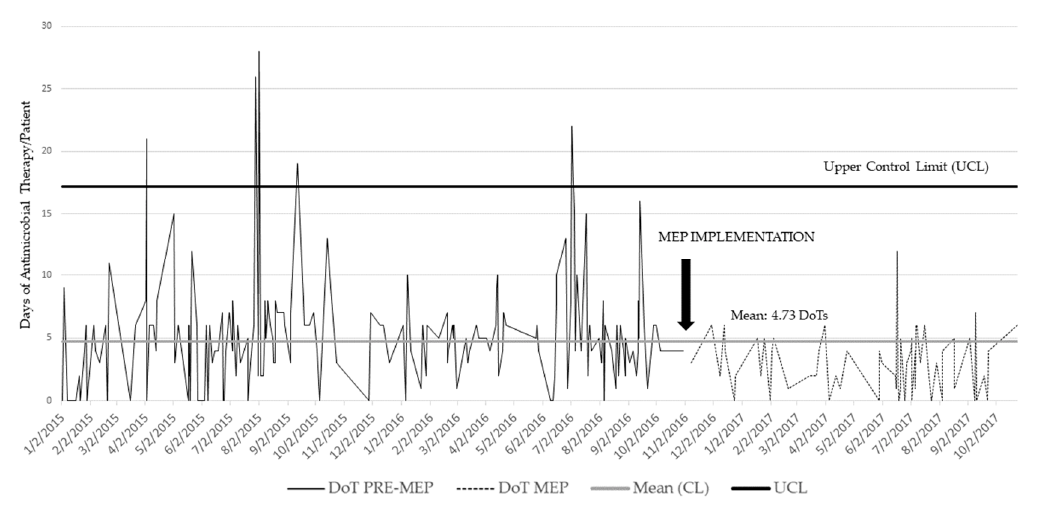
Figure 1. Patient-specific empiric antimicrobial utilization.